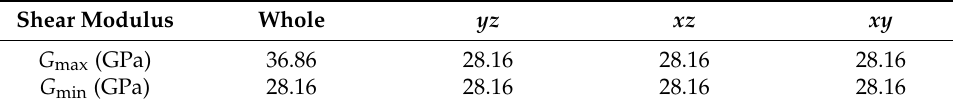
Figure 5. Two-dimensional projections in yz , xz and xy planes of (a) maximum shear modulus and ( b ) minimum shear modulus of Ag 9 In 4 . Table 6. Maximum and minimum values for the shear moduli of Ag 9 In 4 . The maximum and minimum values of the shear moduli are listed in Table 6.